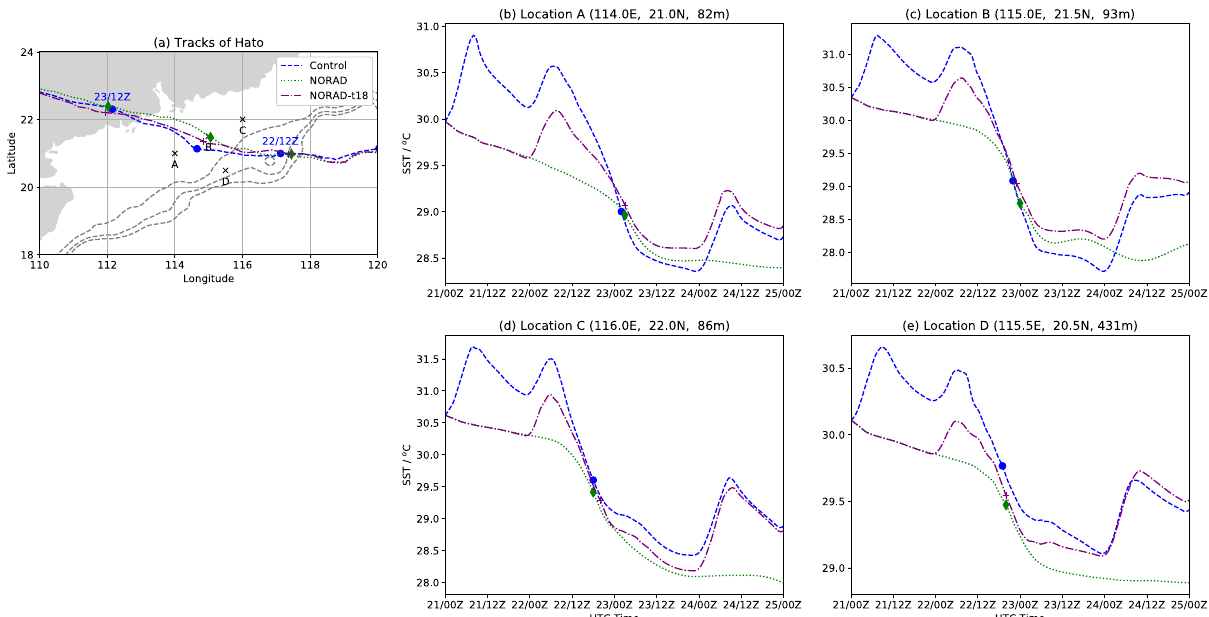
Fig. 2 Time series of SST during the passage of Typhoon Hato. a Simulated tracks of Typhoon Hato with makers at every 12 h, black crosses at the locations of the time series, and ocean isobaths of 200, 600, and 1000 m in gray dashes. b – e Time series of SST at the four locations crossed in a along the edge of continental shelf during the passage of Typhoon Hato in the control (blue dashed), NORAD (green dotted) and NORAD-t18 (purple dash-dotted) experiments. Markers indicate Typhoon Hato ’ s closest time of approach.